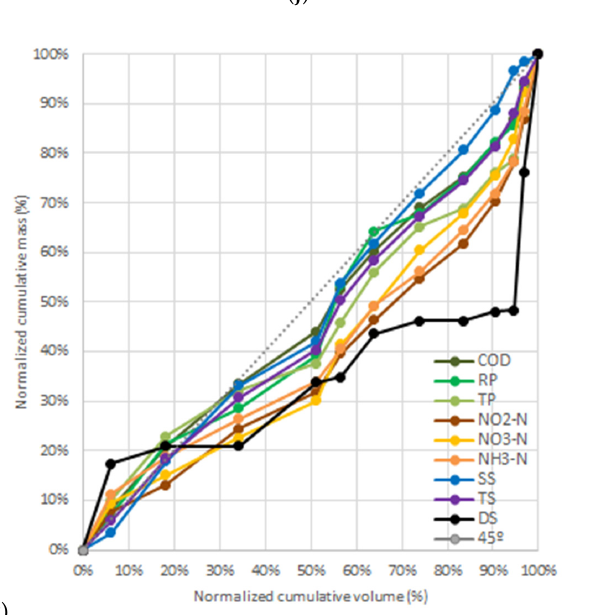
Figure 5. First flush effect during each event: ( a )19 February 2018; ( b ) 4 March 2018; ( c ) 13 March 2018; ( d ) 1 August 2018;